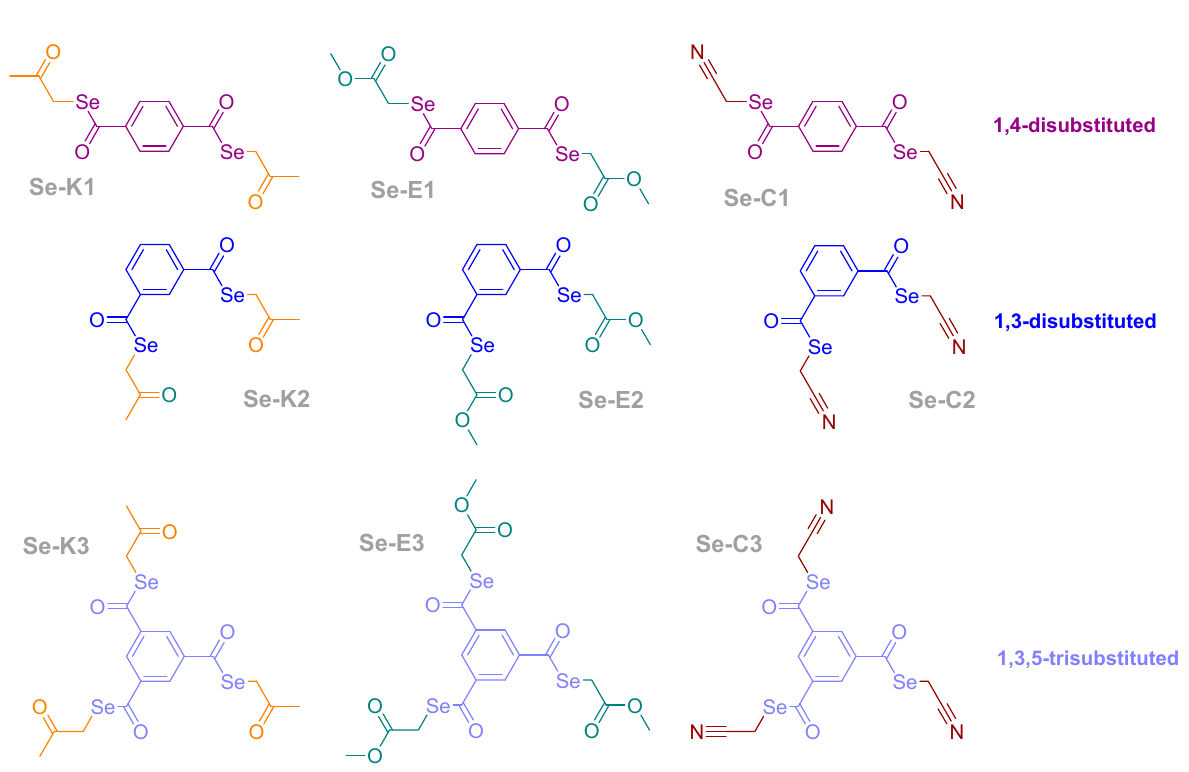
Scheme 1. Symmetrical selenoesters evaluated. Colors are used to indicate the functional groups and the poli-substitution pattern characteristic of each compound, as shown in the